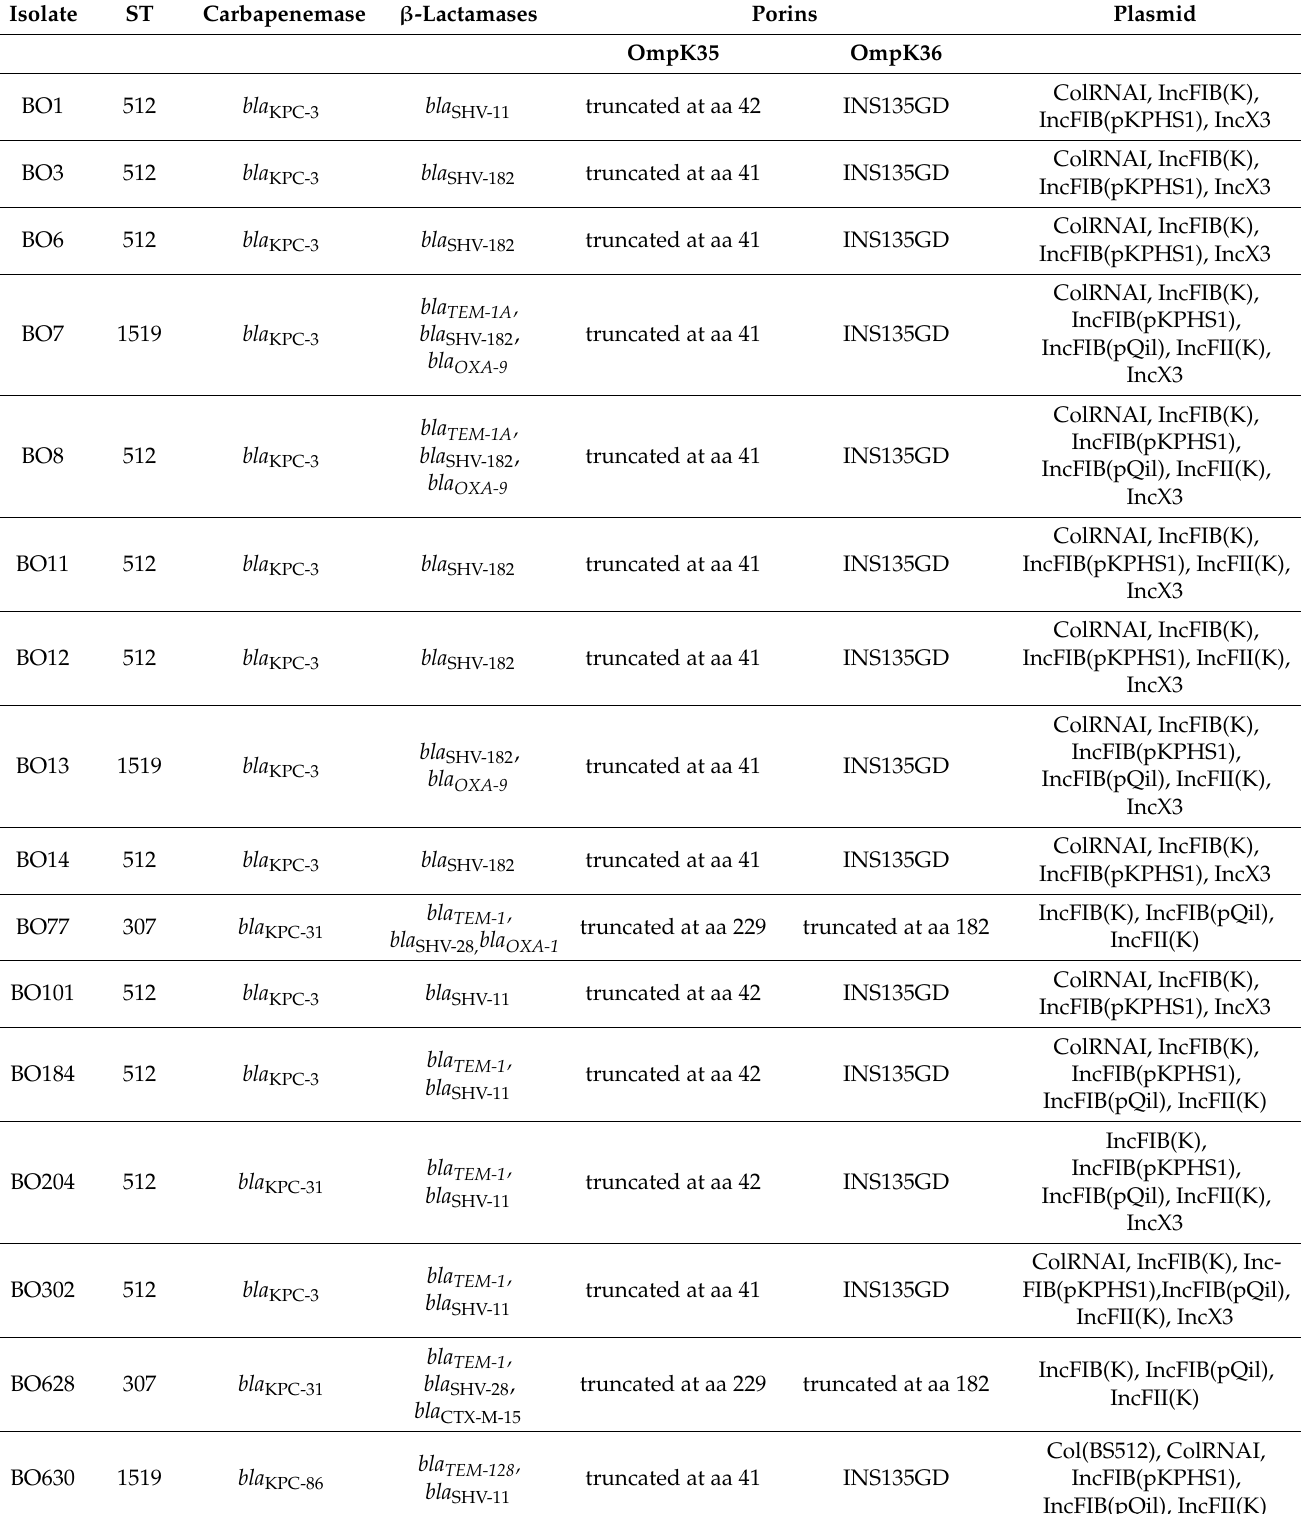
Table 3. Genotypic characteristics of KPC-Kp strains included in this